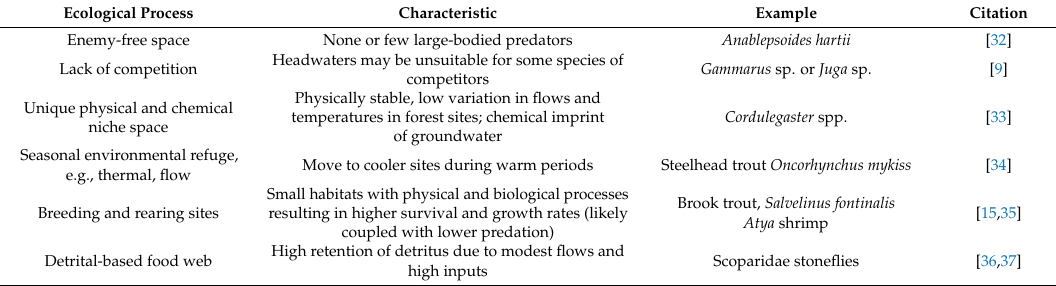
Table 2. Species’ uses of headwaters for particular functions that differentiate headwaters from other freshwater environments: The characteristics of these sites vary geographically depending on forest cover, topography and extent of groundwater inputs, and thus, these are